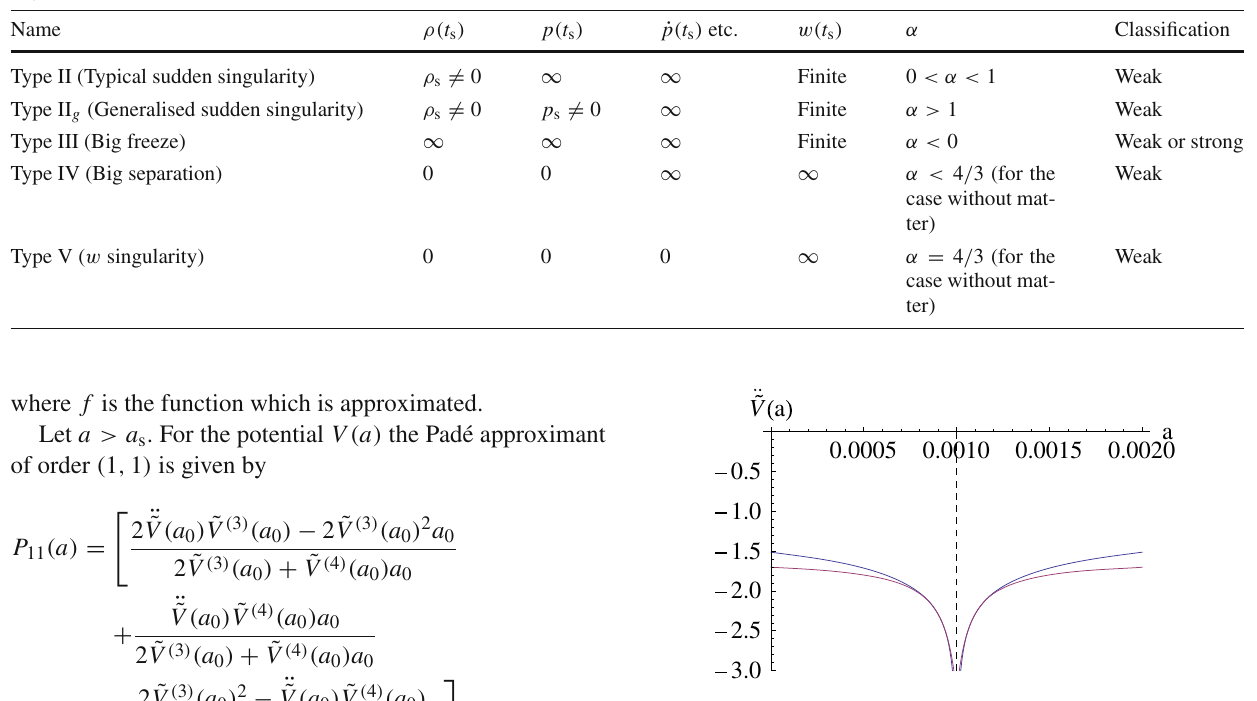
¨˜ Fig. 6 The diagram presents V ( a ) (top curve) and an approximation ¨˜ V ( a ) byPadéapproximant(bottomcurve)forthegeneralisedsudden of singularity. The dashed line presents the generalised sudden